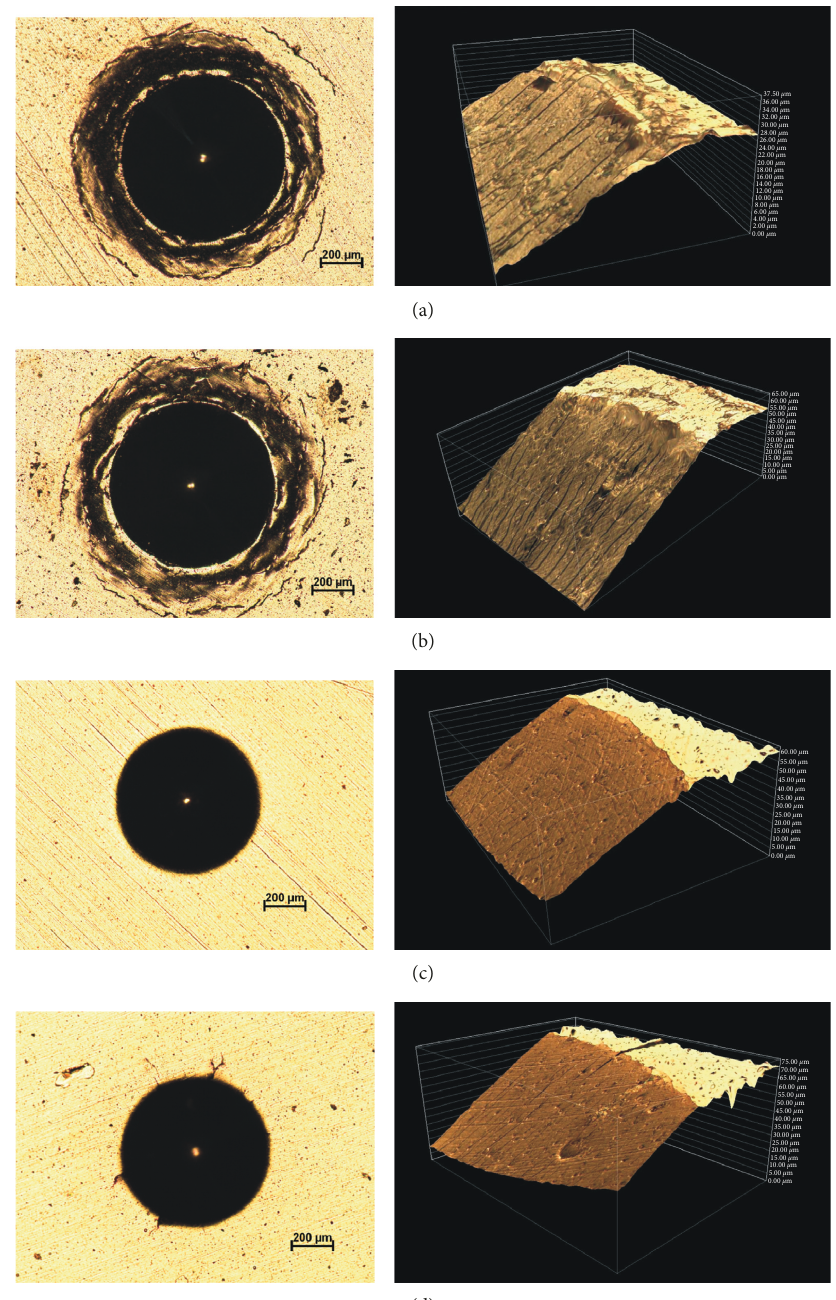
Figure 17: Failure modes after Daimler–Benz test (left column) and 3D visualization of the selected indent morphology (right column) for CrN coatings deposited on (a) initial substrates, (b) shot-peened substrate ( t � 600 s, p � 0.45MPa), (c) nitrided substrate ( t n � 3 h), and (d) shot-peened ( t � 600s, p � 0.45MPa) and nitrided substrate ( t n � 3